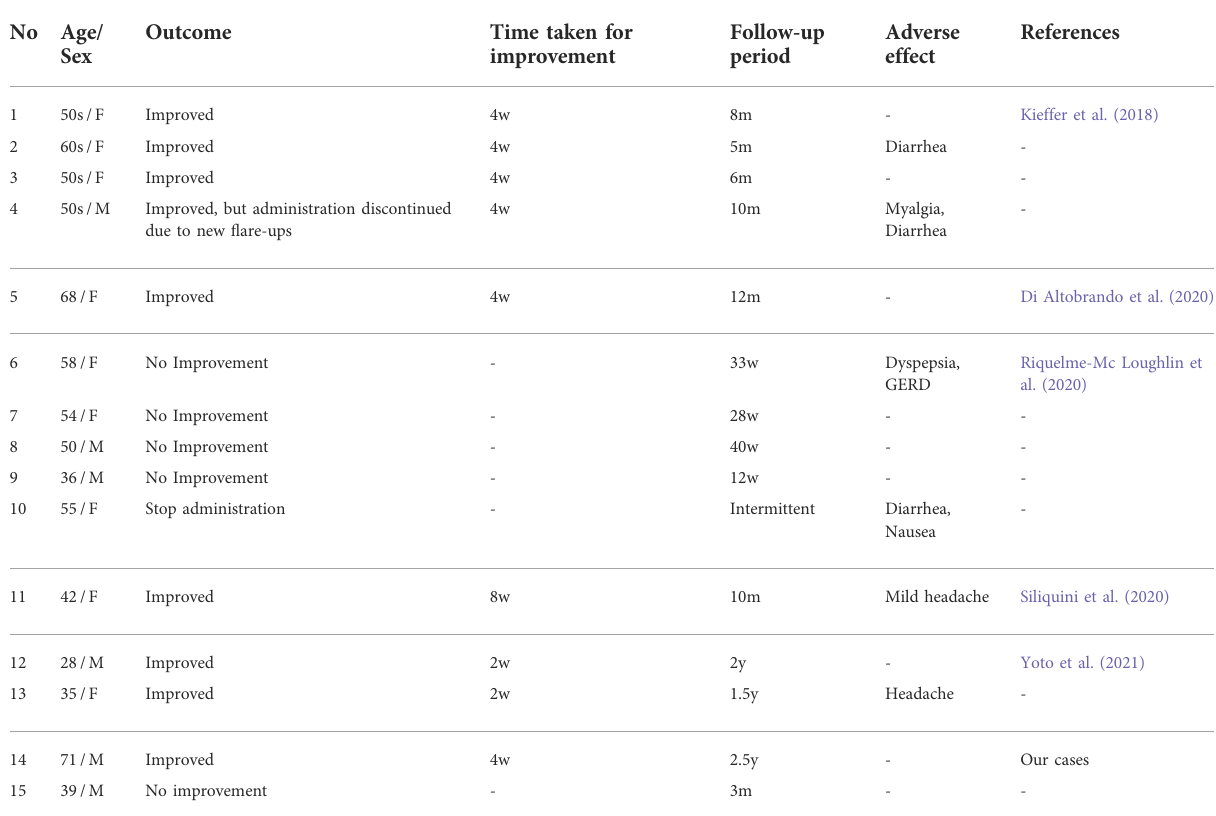
TABLE 1 Summary of all published work on HHD treated with apremilast.